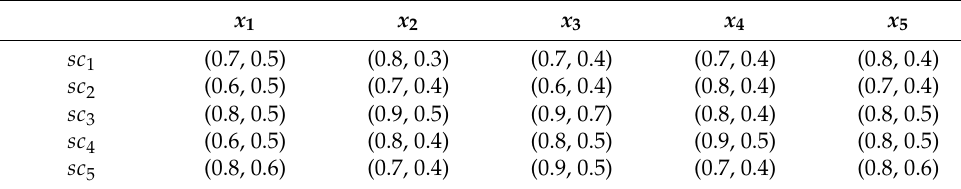
Table 3. Appraisal matrix A 1 by DM-1.